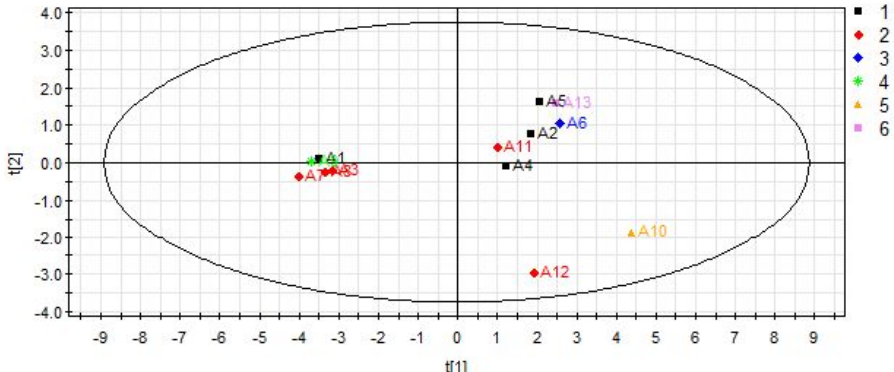
Figure 6. PLS-DA score scatter plot for samples collected from different areas in China. (1) Jilin; (2) Gansu; (3) Shan’anxi; (4) Sichuan; (5) Hubei; (6) Liaoning. The sample numbers in the plot were in accordance with the batch numbers in Table 1 (R2X = 0.761, R2Y = 0.220, Q2 = 0.135).